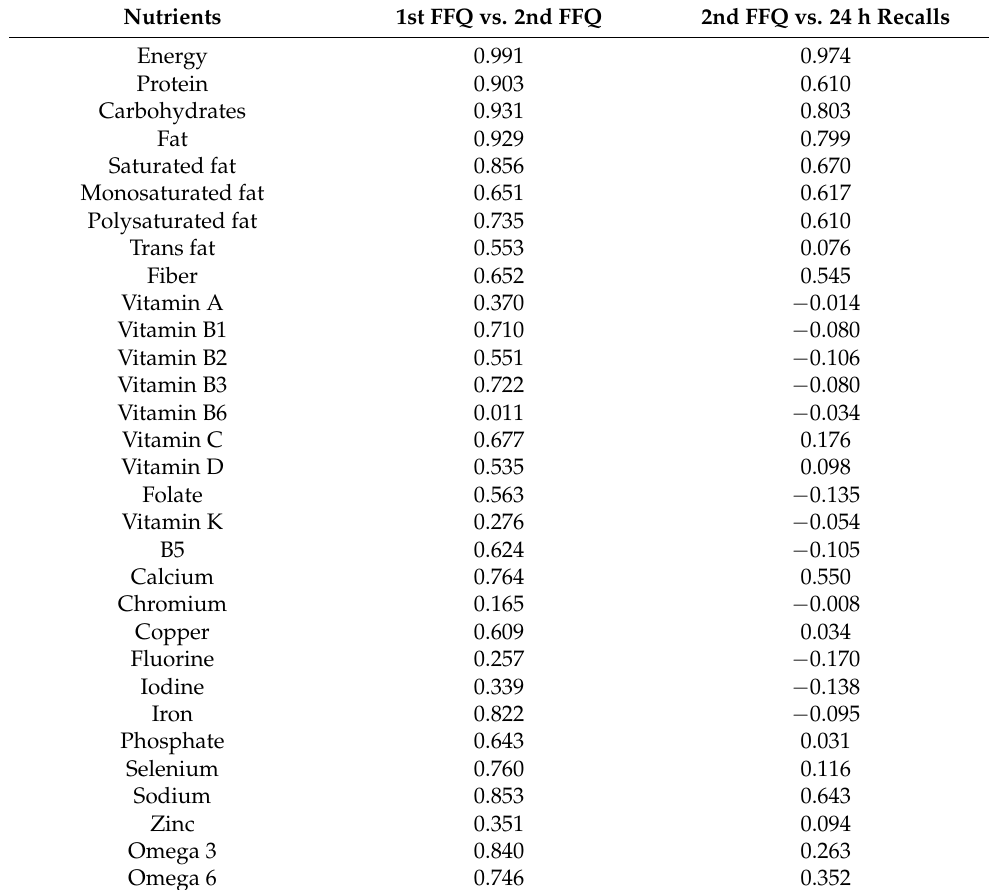
Table 2. Pearson’s correlation of nutrients intake between two FFQ, 24 h